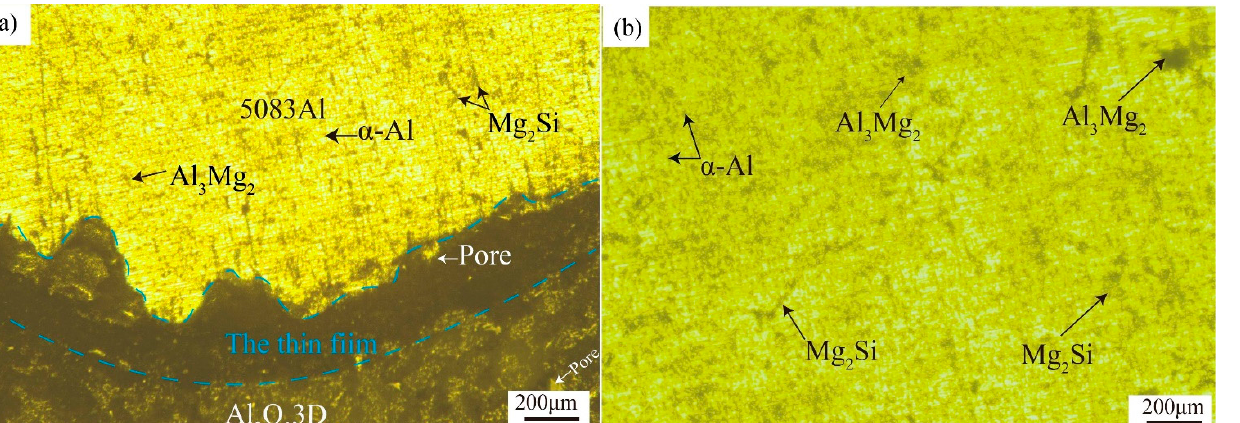
9.879 Figure 4. ( a ) Open circuit potential (OCP) curve; ( b ) potentio-dynamic polarization (PDP) curve.